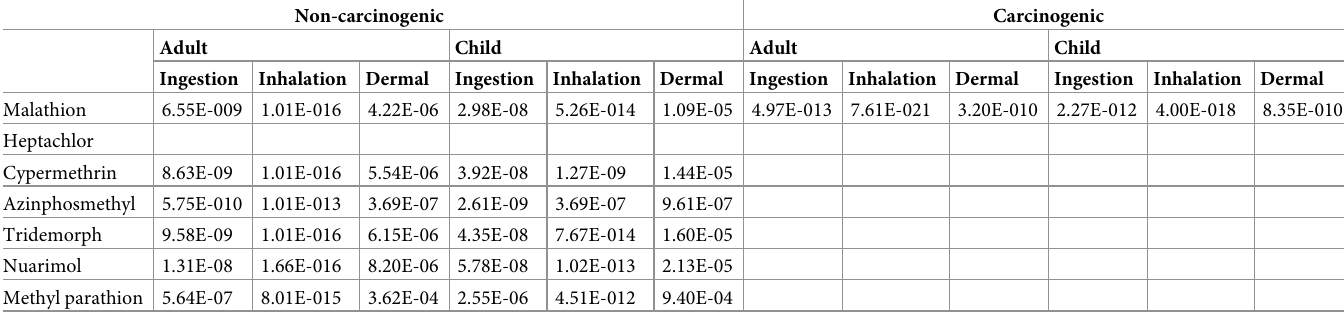
Table 2. Estimation of Chronic daily intake (CDI) and hazard quotient (HQ) for pesticide residues in sediment from Upper stretch.